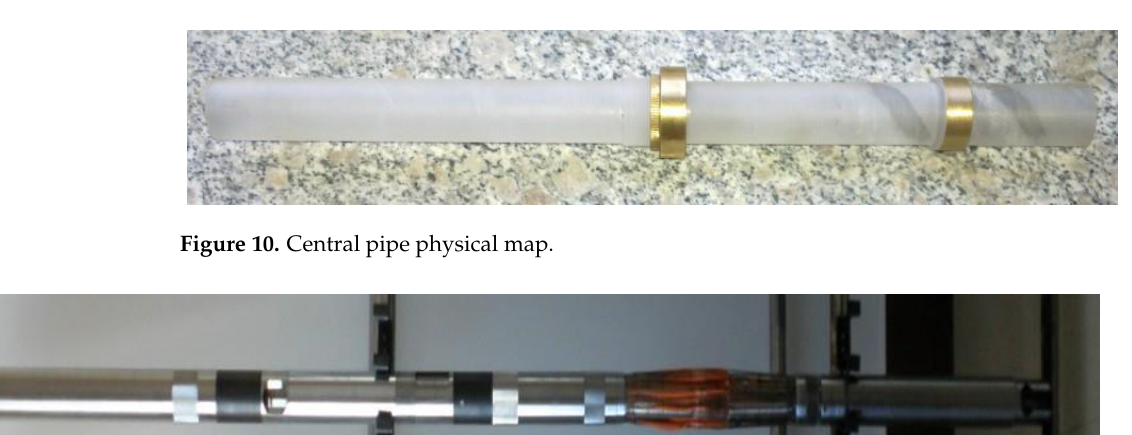
Figure 10. Central pipe physical map.